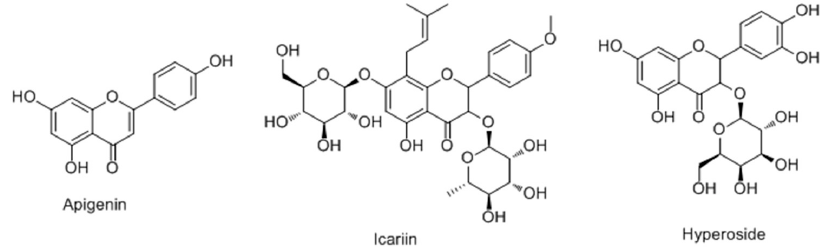
Figure 15. Structures of three compounds with activator effect on tyrosinase .